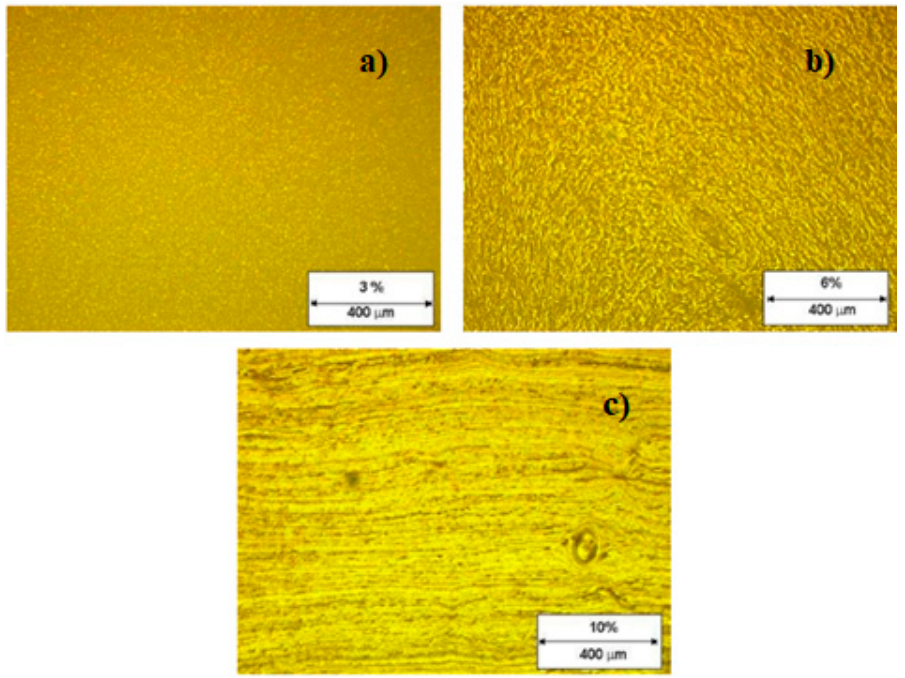
Figure 6. Dispersion of: ( a ) 3%, ( b ) 6%, and ( c ) 10% ( w / w ) of linear SBS obtained by fluorescence microscopy (reprinted from [65] with the permission of the American Chemical Society). Appl. Sci. 2019 , 9 , x FOR PEER REVIEW